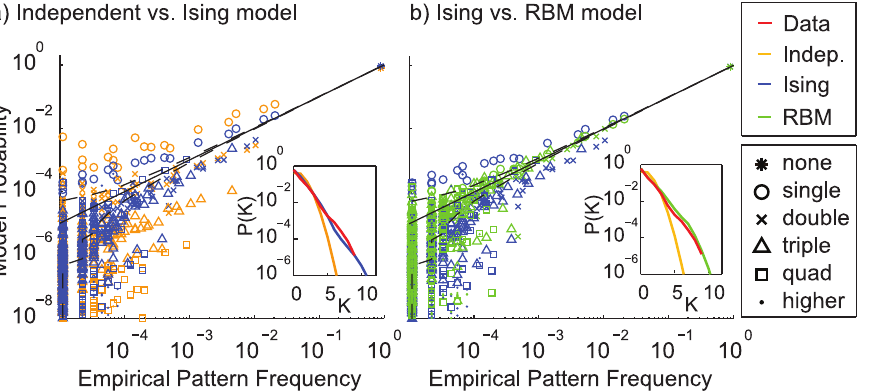
Figure 4. Scatter plot showing empirical probabilities against model probabilities on T6 test dataset. Different models are distinguished by color, the number of simultaneously spiking cells in each pattern by different symbols. ( a ) shows the independent model compared to the Ising model, ( b ) shows the Ising model compared to the RBM. The sRBM is omitted as it is very similar to the RBM. The RBM significantly outperforms simpler models. Inserts in both models show the distribution of synchrony, P ( K ) , where K is the number of cells simultaneously firing in one time bin. The synchrony in the empirical distribution (red line) is greatly underestimated by the independent model (yellow), but well captured by both the pairwise (blue) and higher-order model